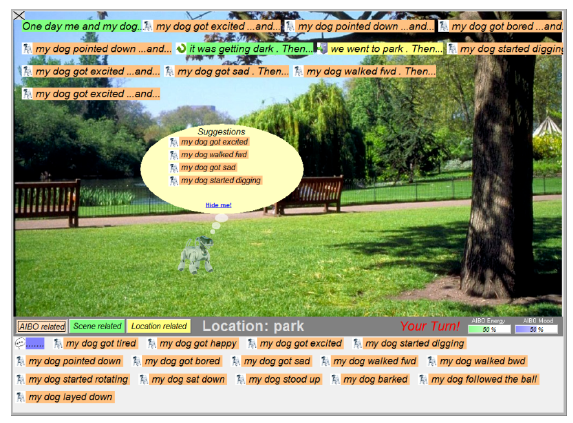
Figure 2. The graphic user interface of the AIBOStory.